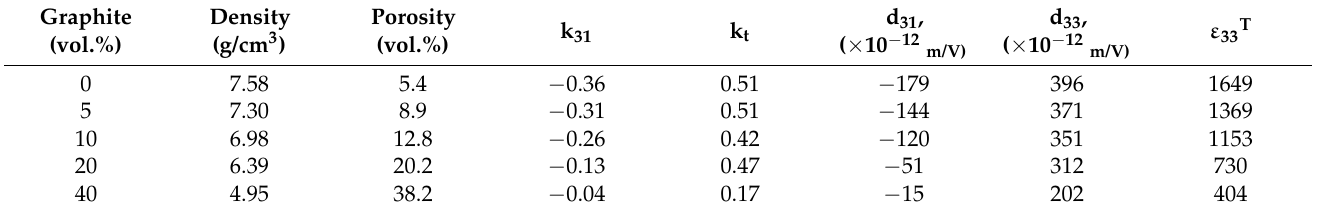
Table 5. Physical and electrical properties of the samples at different porosity (Reprinted from Ref. [91], copyright (2005), with the kind permission of Elsevier